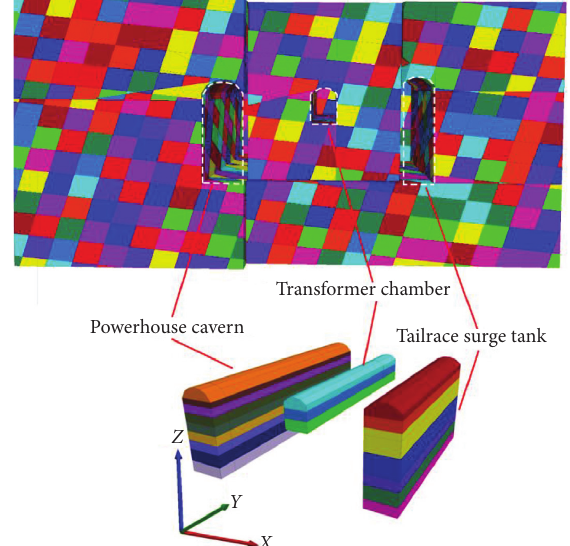
Figure 5: Structures and the DFN model of Dagangshan power- house caverns.